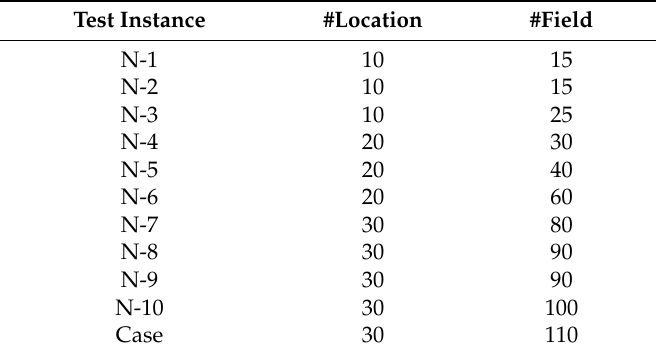
Table 13. Parameter setting of test instances.